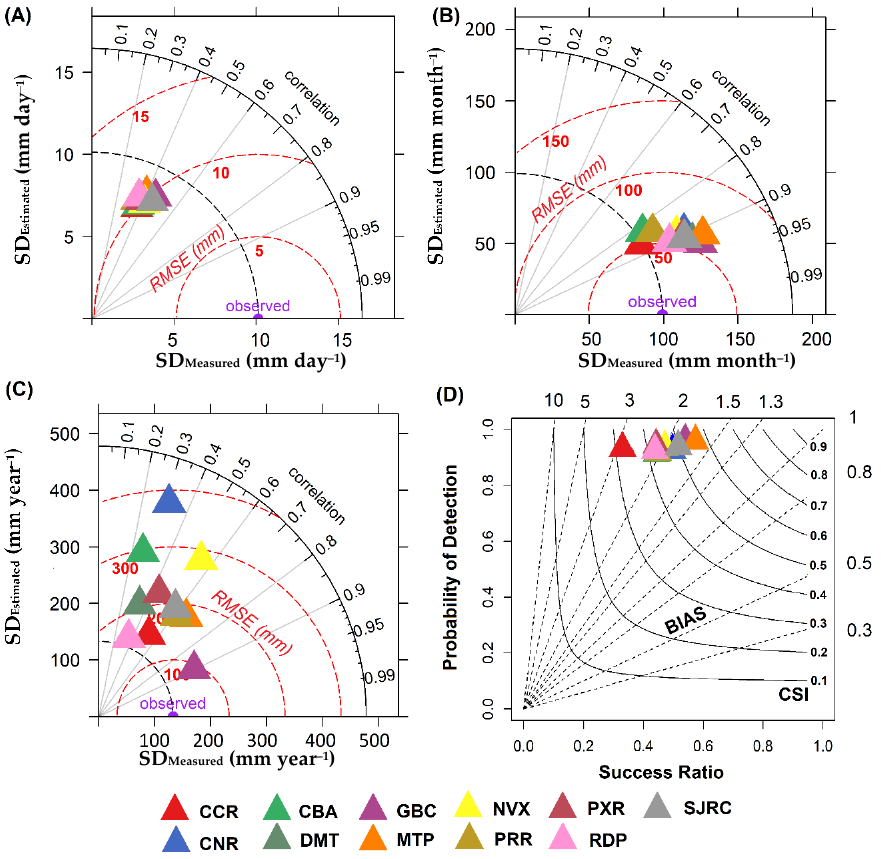
Figure 6. Taylor diagrams showing the comparisons of ( A ) daily (mm day −1 ), ( B ) monthly (mm month −1 ), and ( C ) annual (mm year −1 ) measured and estimated precipitation, as well as ( D ) the performance diagram of the GLDAS product at each of the weather stations in the state of Mato Grosso, Brazil. In panels ( A – C ), the Pearson correlation coefficient (r) is represented by the azimuth angle (black outlines), the RMSE was represented by the red dashed outlines, and the standard deviation (SD) was indicated by the x and y axes, respectively. In panel ( D ), the probability of detection (POD) is represented on the x and y axes; the BIAS was indicated by the dashed black lines; and the critical success index (CSI) is represented by continuous black lines. For ( A ), the daily values for the entire study period were averaged, while for ( B ), the total monthly values for all months during the study period were averaged, and the annual values in ( C ) were the annual values averaged for all years during the study period.